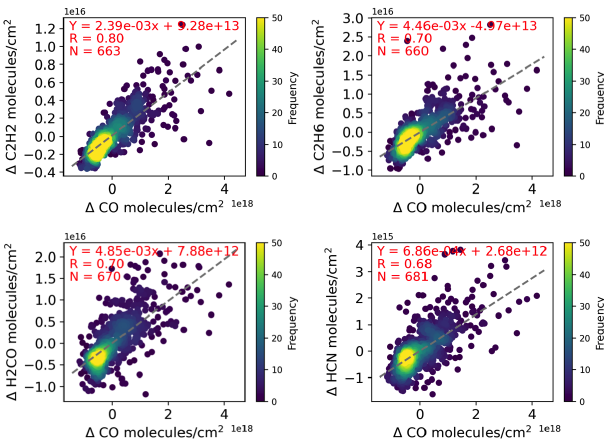
Figure 6. The correlation plot between (cid:49) CO (CO minus monthly mean) and (cid:49) C 2 H 2 , (cid:49) C 2 H 6 , (cid:49) H 2 CO, and (cid:49) HCN daily means. The dots are colored according to their frequency. The dashed gray line is the linear fit. R is the Pearson correlation coefficient. N is the co-located